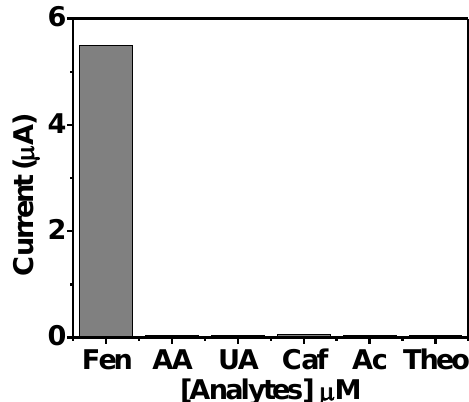
Figure 5. The selectivity performance of polymeric microneedle-based fentanyl sensor toward prospective interfering analytes. The bar graph illustrates the current values obtained by SWV response of fentanyl (50 mM), ascorbic acid, uric acid, caffeine, acetaminophen, and theophylline (all these tested interfering analytes were at the concentrations of 1,000 mM).